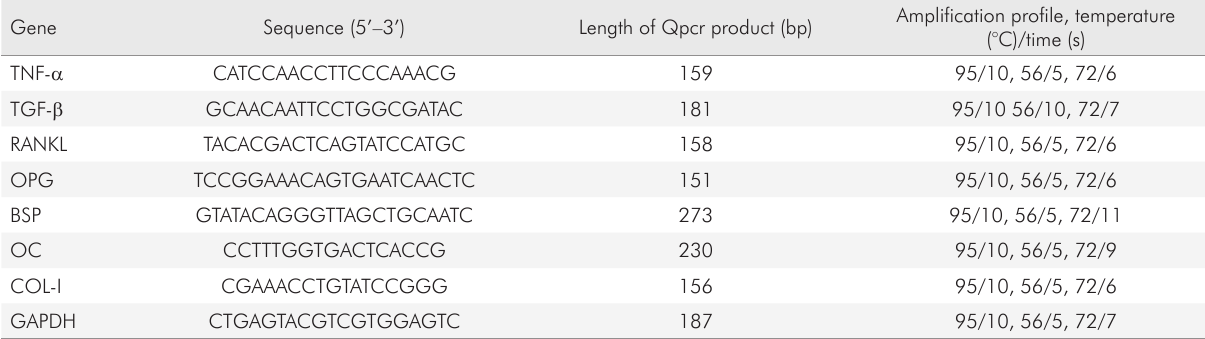
Table 1. Primer sequences for each gene, amplification profiles and estimated length of the qPCR product for each gene. Gene